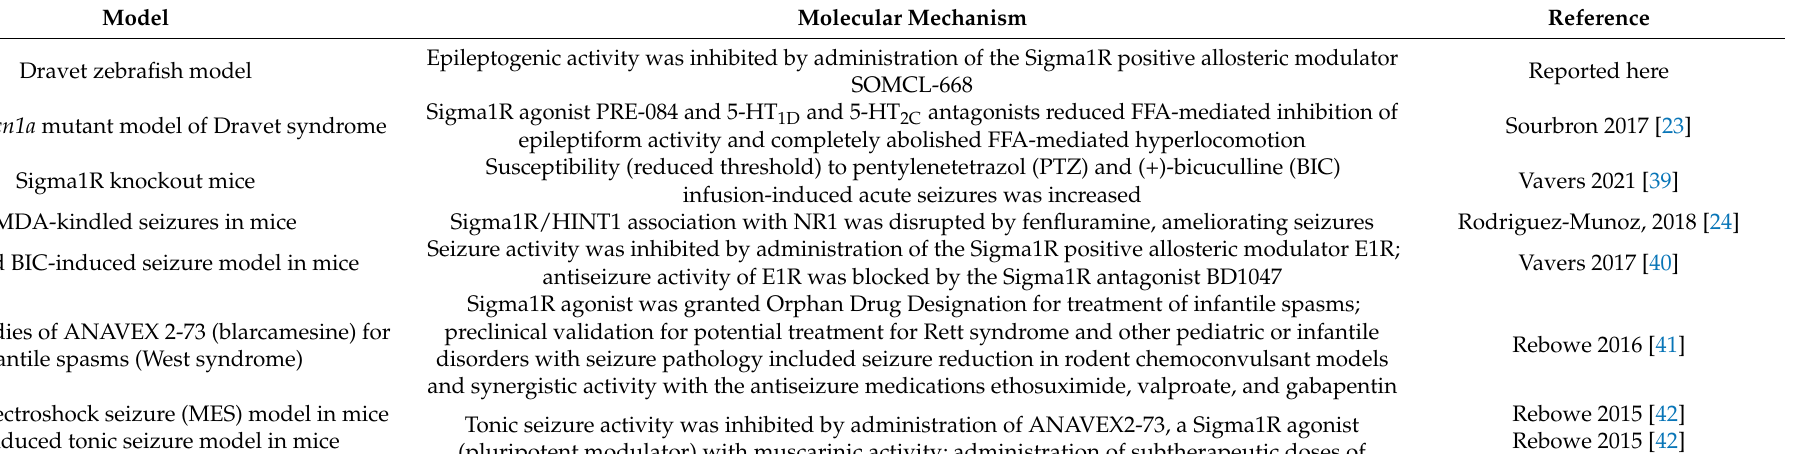
Table 2. Role of Sigma1R in seizures and